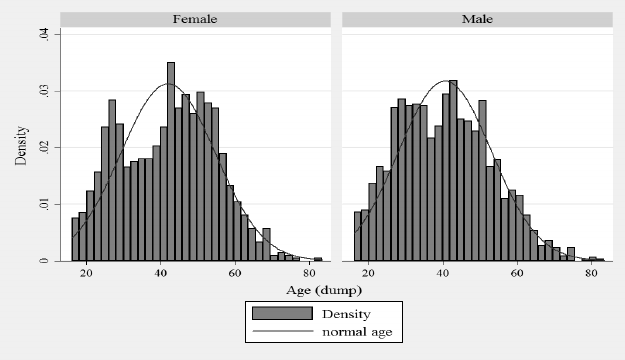
Figure 1 : Age distribution (kernel density) of online dating users by sex